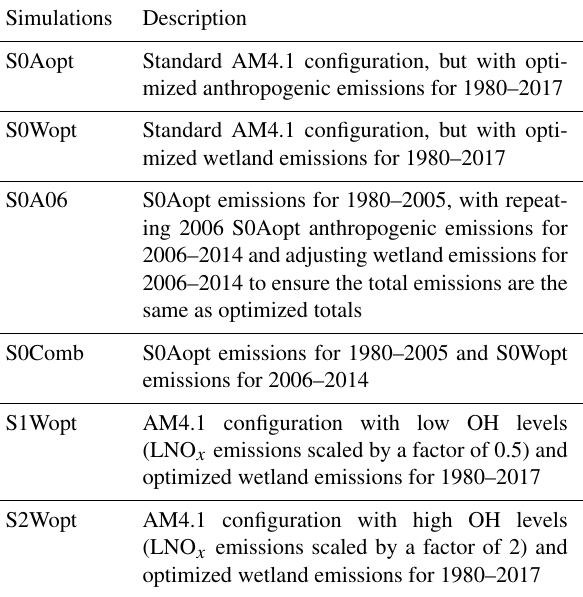
Table 2. List of simulations conducted using GFDL-AM4.1 to ex- plore trends and variability in